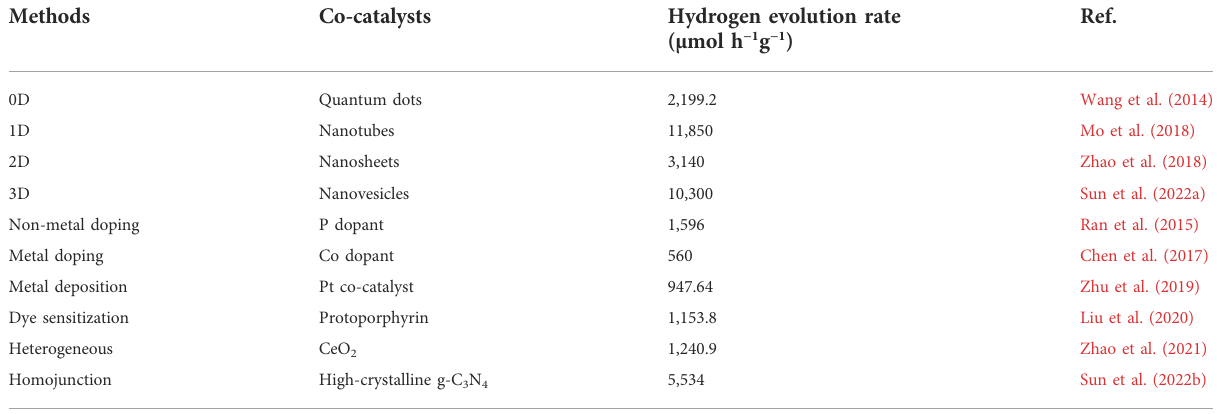
TABLE 1 Hydrogen evolution performance of the modi fi ed g-C 3 N 4 -based materials.